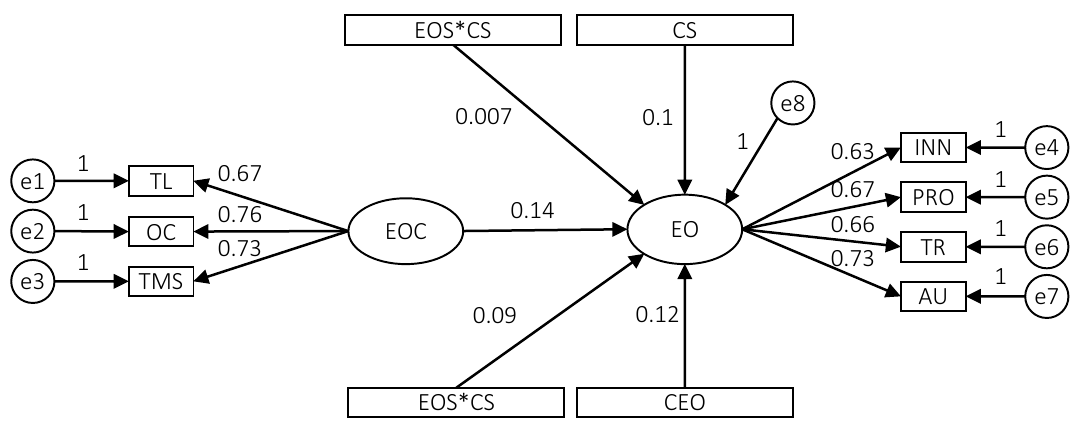
Figure 2. Structural model